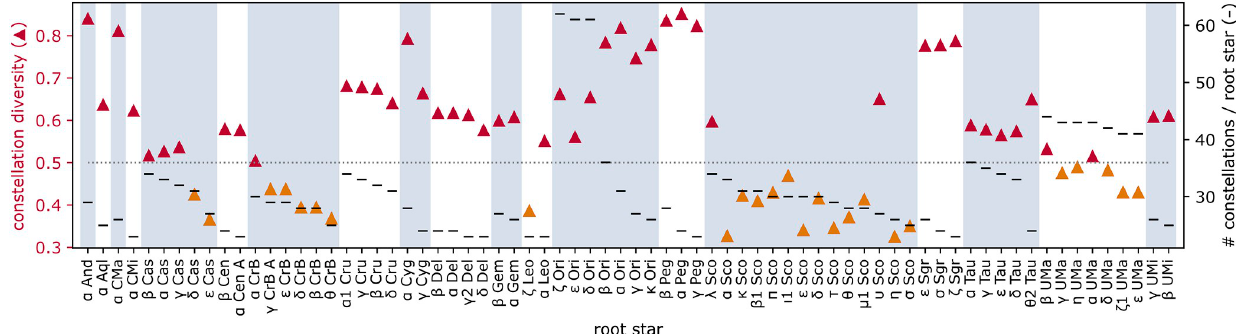
Fig 9. Diversity by root star (II). Per root star, the diversity index H among all constellations with that star (on the left y axis with triangles), and the number of constellations with that star (on the right y axis with dashes). Value 0.5 for diversity is marked with a dotted line, and the diversity markers are coloured differently above and below this. The mean diversity is H = 0.568. The alternating background emphasises root stars from the same IAU constellation.